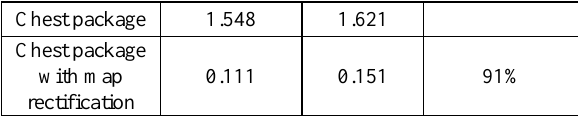
Table 1. Evaluation of map rectification using different platforms